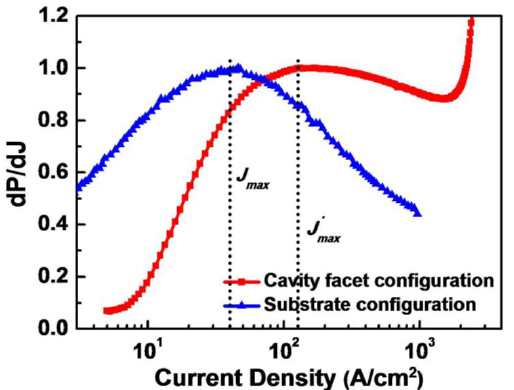
Figure 4. The dP/dJ–J curves of a 405 nm GaN-based LD measured from the cavity facet side (red) and the substrate side (blue), respectively.